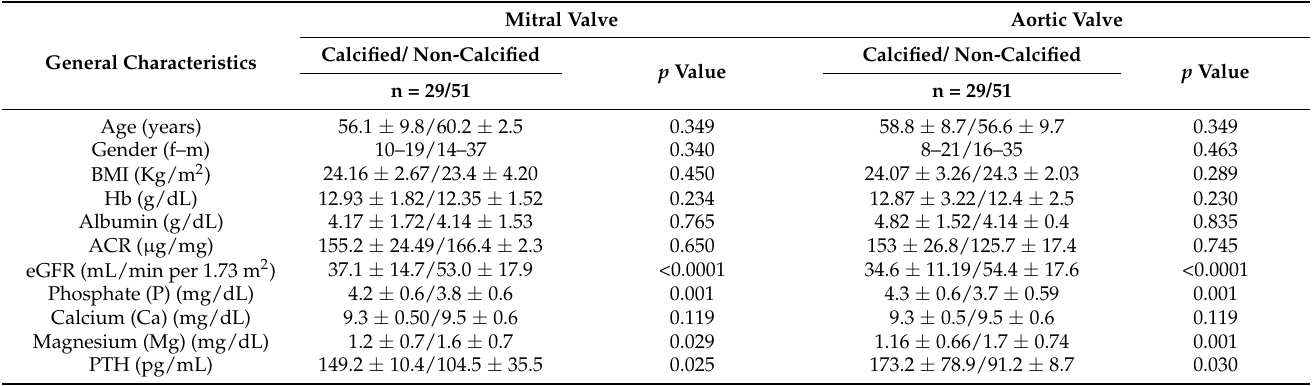
Table 1. Characteristics of the study population according to mitral and aortic valves calcification (n =